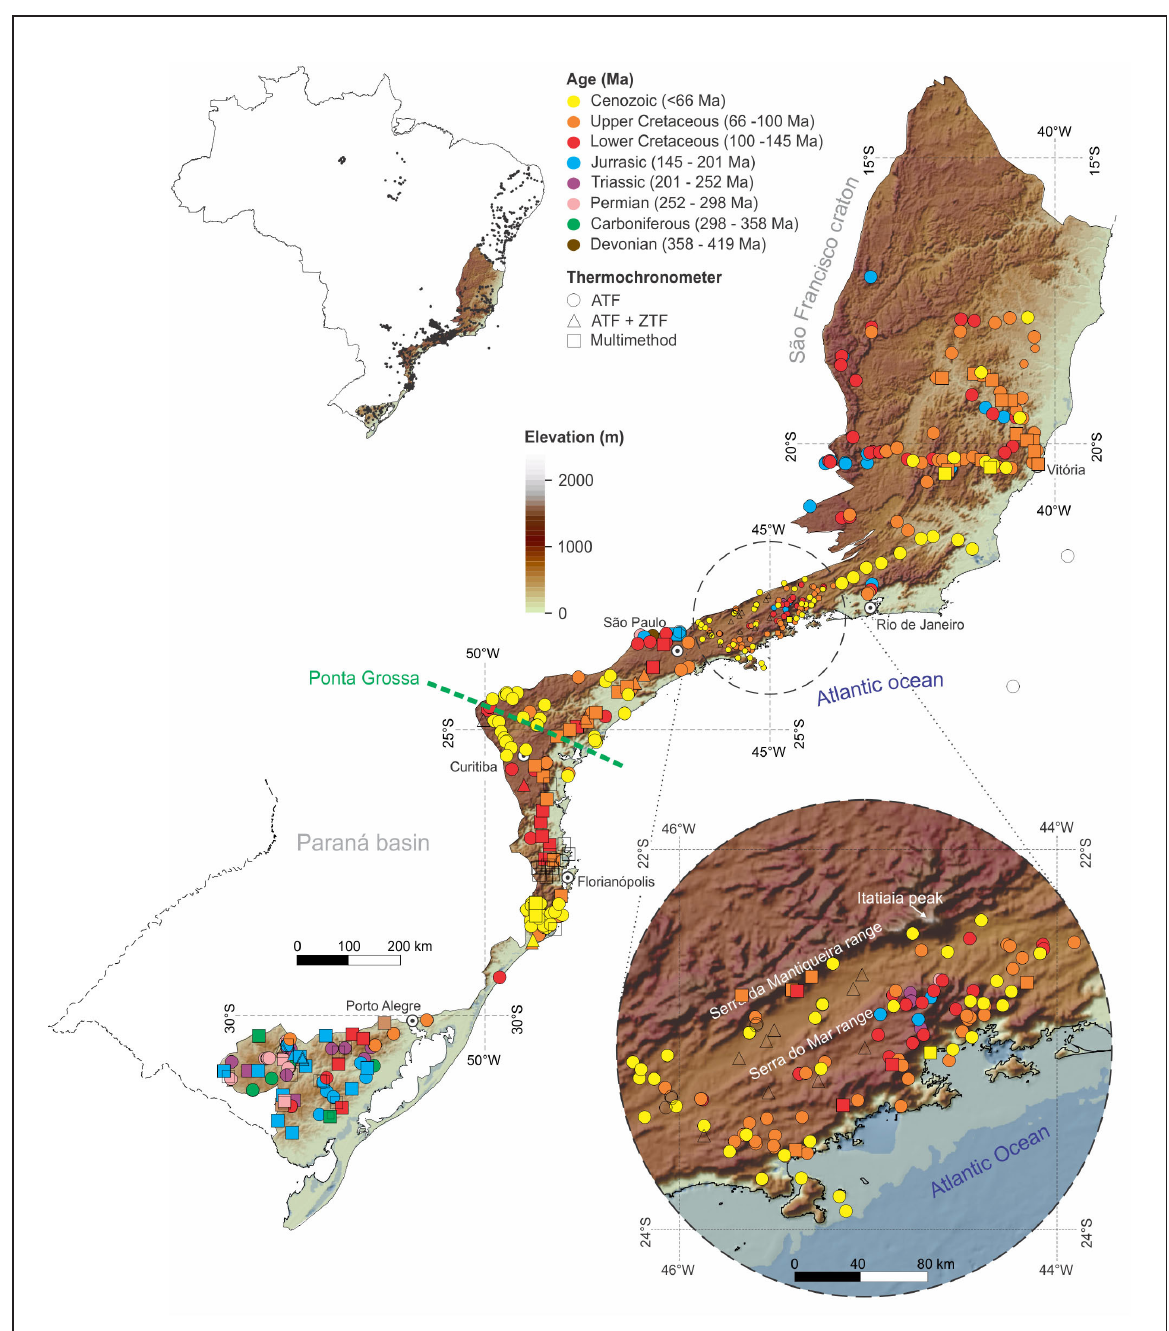
FIGURE 5 . Thermochronological data set available for the Mantiqueira province, the circle below is a zoom highlighting the Serra do Mar range